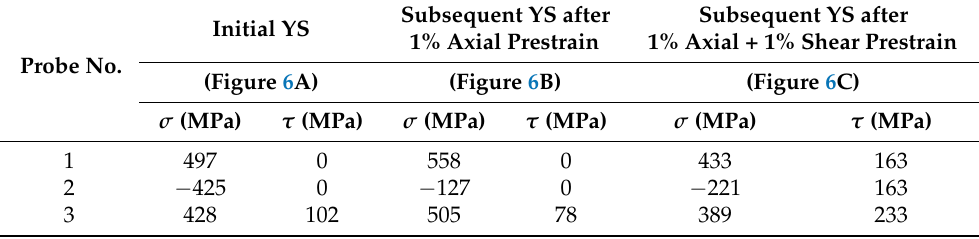
Table A2. Tabular results of YS tracing in S235JR steel—the yield points evaluated within individ- ual